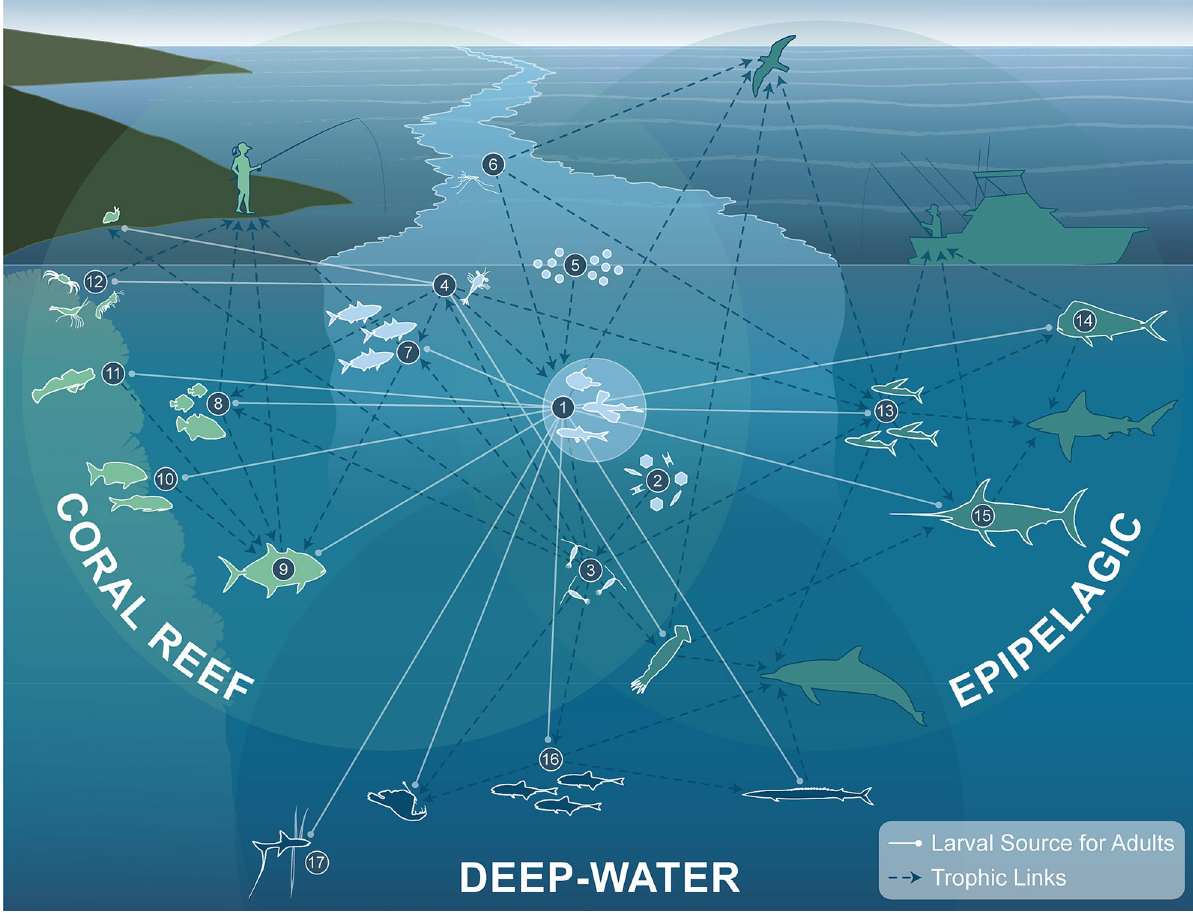
Figure 7. Conceptual diagram illustrating key examples of the ecological connections and functions enhanced by surface slick nurseries. (1) Larval and juvenile stages of fishes from many ocean habitats aggregate in slicks in order to capitalize on dense concentrations of prey (2, phytoplankton, 3, zooplankton, 4, larval invertebrates, 5, eggs, and 6, insects). The increased predator–prey overlap in slicks increases energy flow that propagates up the food-web (dotted blue lines show trophic links), enhancing energy available to higher trophic level predators (icons outlined in blue) including humans. More than 100 species of fishes develop and grow in surface slick nurseries before transitioning to adults (solid white lines radiating outward) in Coral Reefs (7–12), Epipelagic (13–15), and Deep-water (16–17) ocean habitats. As adults these taxa (icons outlined in white) play important ecological functions and provide fisheries resources to local human populations. For example, coastal schooling fishes (7, mackerel scad) are important food and bait fish for humans. Planktivorous fish (8, some damselfishes and triggerfishes) transfer energy from zooplankton up to reef predators 47 like jacks (9), which provide top- down control of reefs 48 and are important targets for shoreline recreational fisherfolk 43 . Grazers (10, chubs) help keep coral reefs from being overgrown by macroalgae 49 . Cryptobenthic fishes such as blennies (11) and benthic macrocrustaceans (12, shrimp, stomatopods, crabs) comprise most of the consumed biomass on reefs 50,51 . In the pelagic ocean, flyingfishes (13) channel energy and nutrients from zooplankton to pelagic predators such as mahi-mahi (14) and billfish (15), both of which utilize slicks as nursery habitat. Larvae of mesopelagic fishes like lanternfish (16) and bathydemersal tripod fishes (17) utilize these surface hotspots before descending to deep- water adult habitat. Surface slicks are clearly the focal point for numerous trophic and larval connections that are foundational for marine ecosystem function. For clarity, the diagram only illustrates several key examples and does not represent the full breadth of ecological connections enhanced by surface